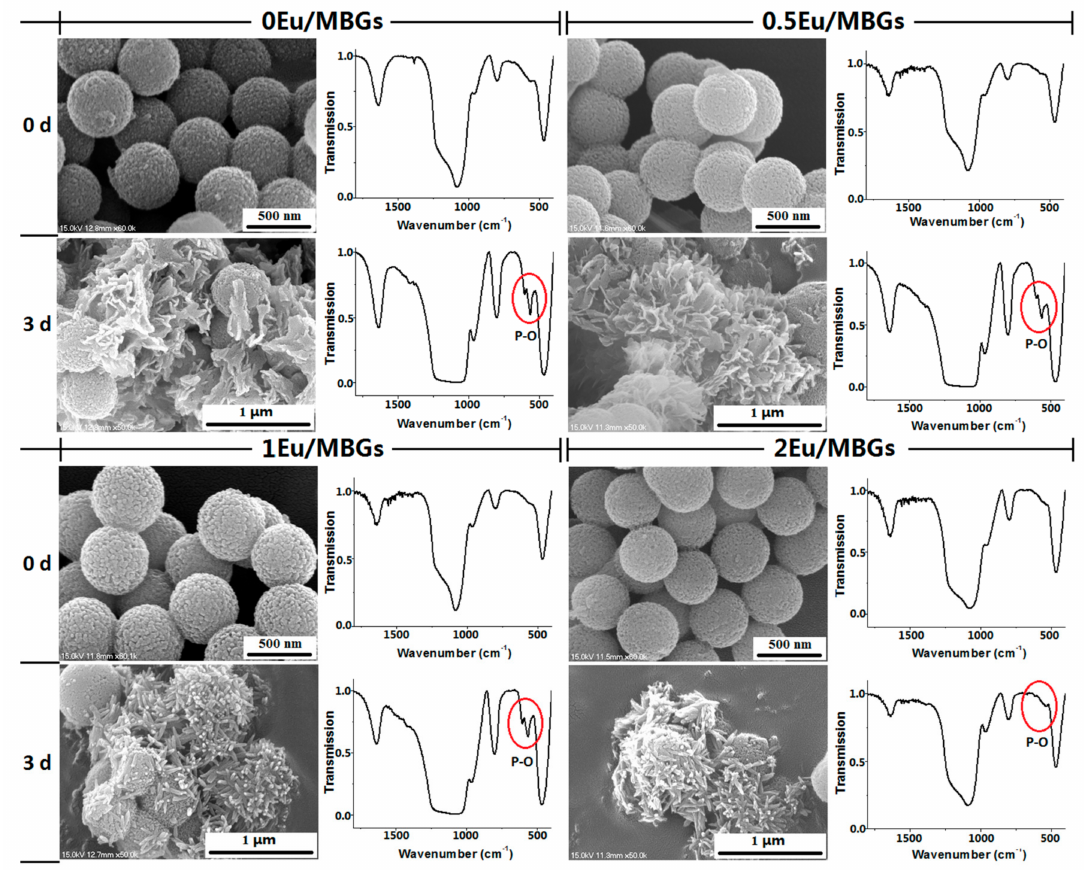
Figure 4. Scanning electron microscopy (SEM) micrographs and Fourier transform infrared (FTIR) spectroscopy analysis of Eu/MBGs after soaking in SBF for 0 and 3